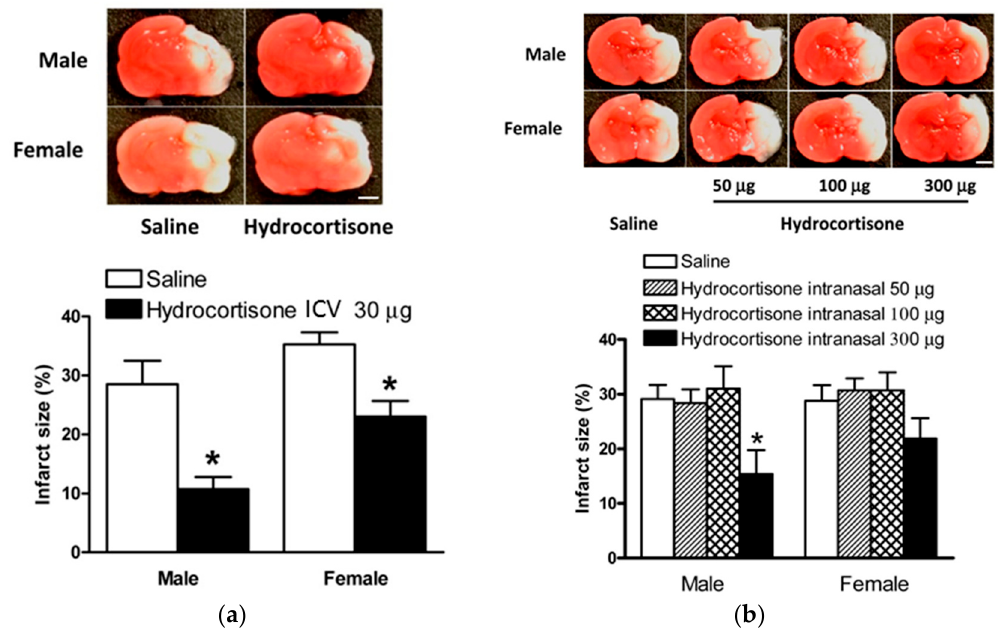
Figure 3. Hydrocortisone treatment after HIE injury. Hydrocortisone via ICV injection or intranasal instillation administered 2 h after HIE insult. Representative brain slices are shown above.